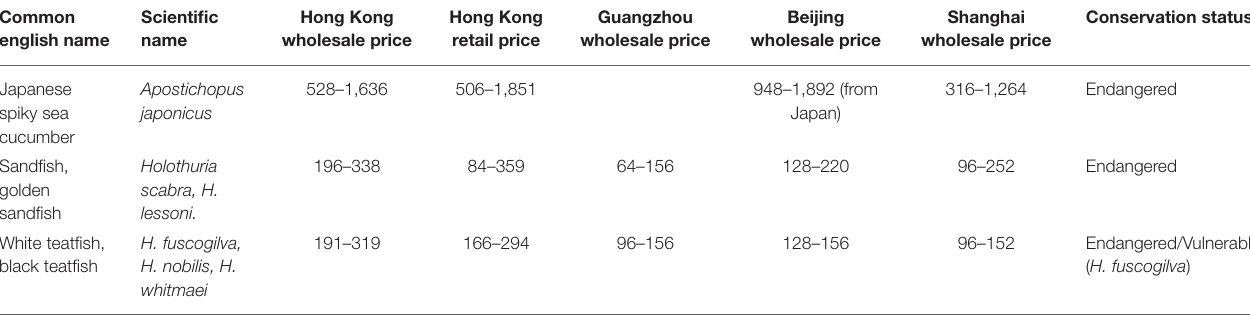
TABLE 3 | Prices of selected sea cucumbers in USD/kg, September